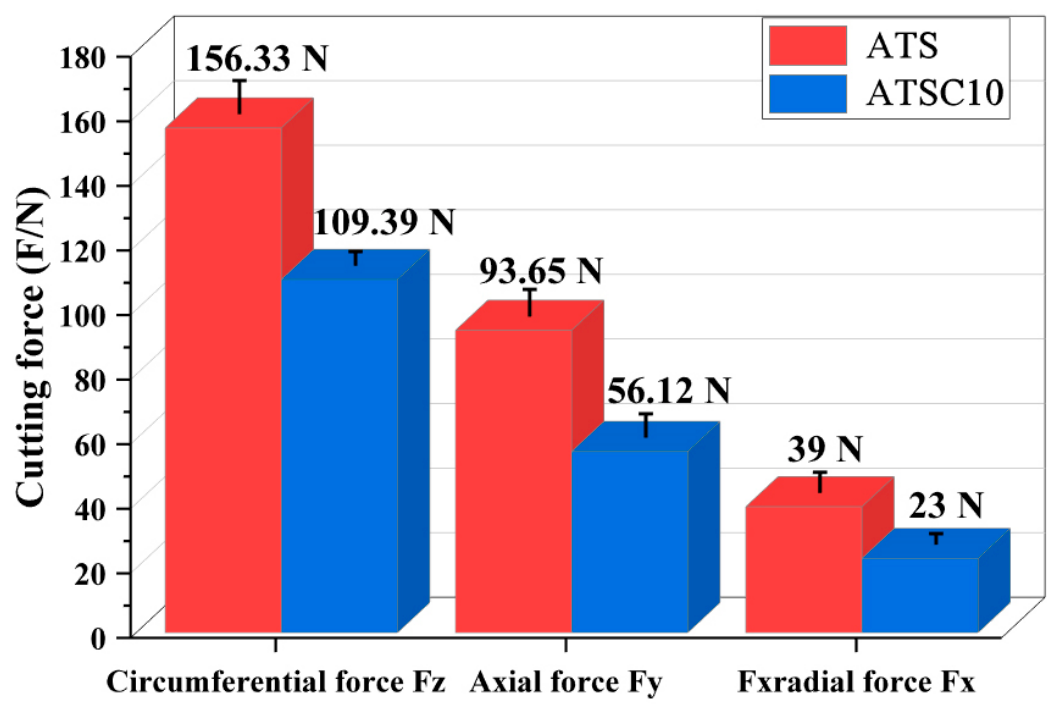
Figure 10. Comparison of cutting forces of the two types of tools.